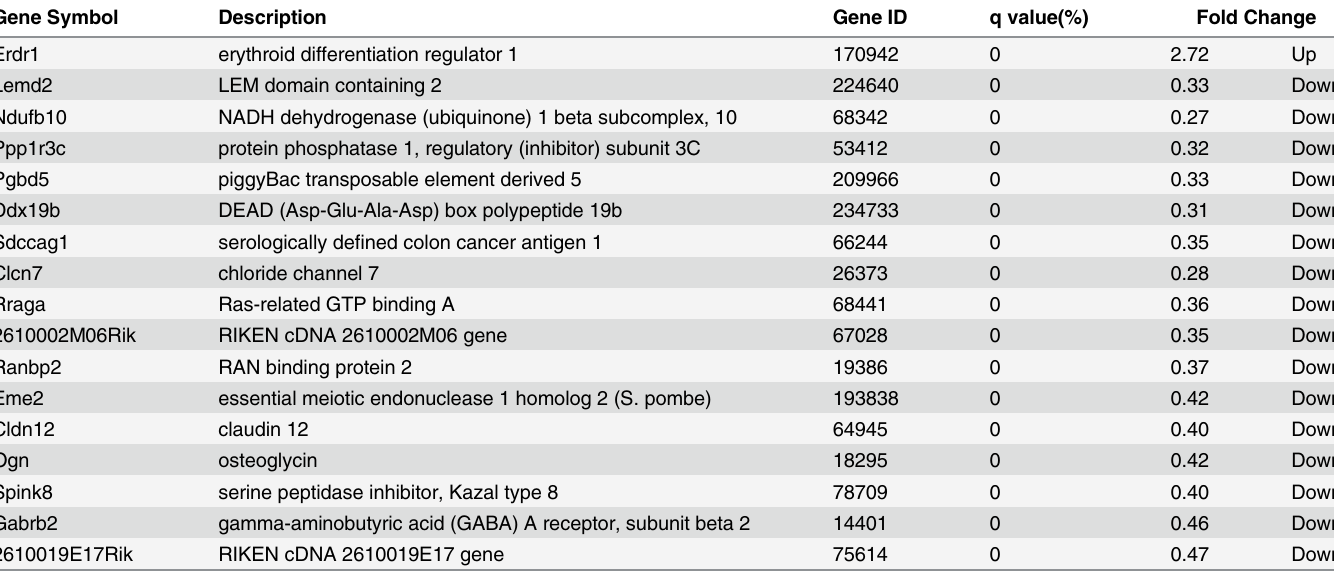
Table 6. Differentially expressed genes in KTR vs WTR